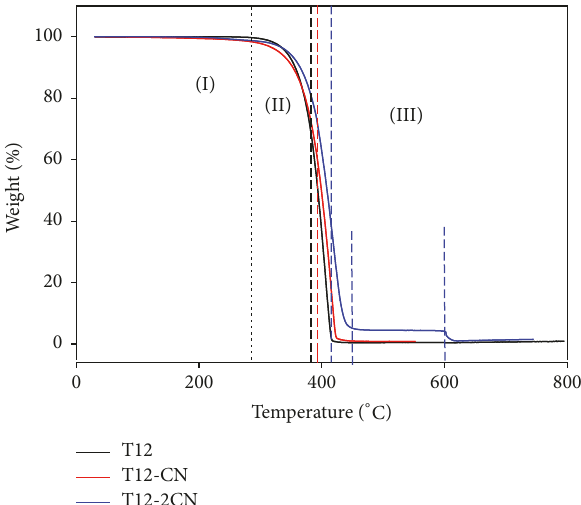
Figure 3: TGA thermograms for the synthesized terphenyls.